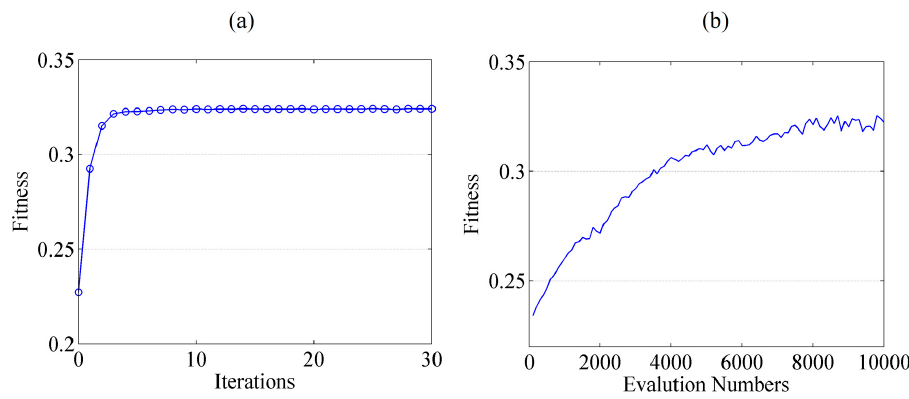
Figure 11. Fitness values of the proposed process ( a ) and GA ( b ). Table 9. Objective values of the proposed and GA land-use allocation processes compared with the current status.